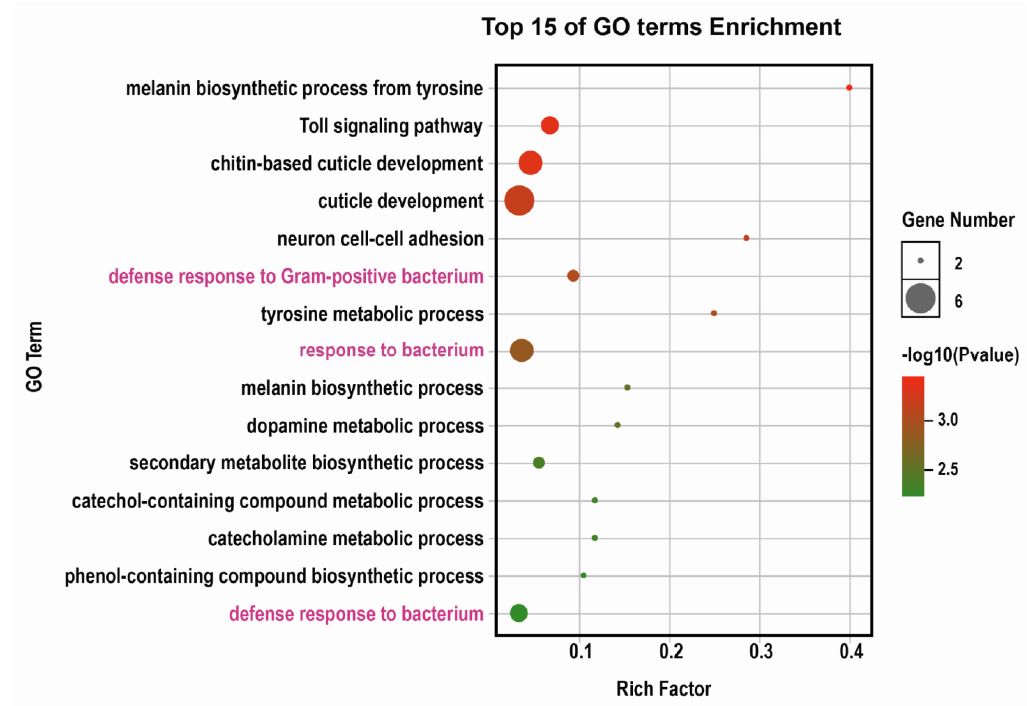
Figure 3. GO enrichment analysis of biological processes involved in the DEGs among female adults. GO enrichment study was performed using OmicShare tools. For data regarding GO terms, see Table S1.